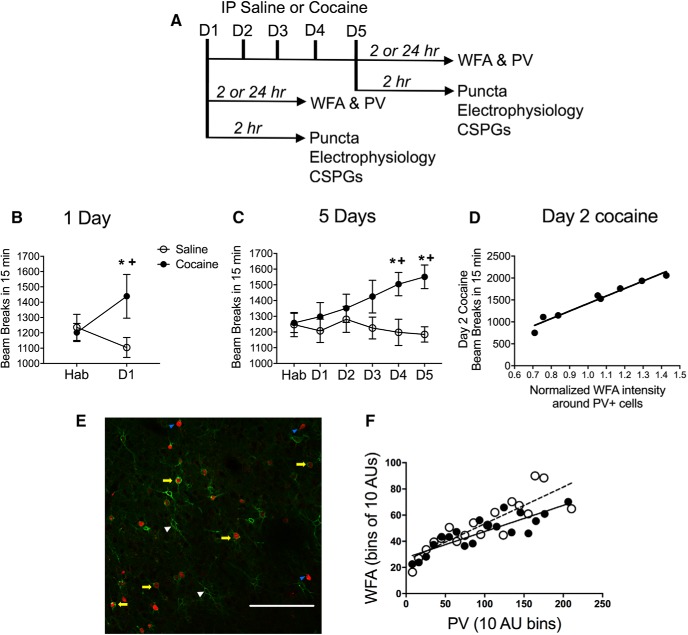
Cocaine exposure increases locomotor activity, and PV intensity is correlated with WFA intensity. Data are the mean ± SEM. A, Timeline of experiment. B, Infrared photocell beam breaks the first 15 min after saline or cocaine injection (15 mg/kg, i.p.). A single cocaine exposure increased the locomotor response compared with the habituation (Hab) day. C, Repeated cocaine increased locomotor activity compared with their Hab day and with saline controls on day 4 (D4) and D5. D, Significant positive correlation between WFA staining intensity in WFA+/PV+ cells and cocaine-induced locomotor activity on day 2 when intensity was examined 2 h after 5 d of cocaine exposure (Fig. 1-1, available at https://doi.org/10.1523/ENEURO.0221-18.2018.f1-1, for all correlations). E, Representative photomicrograph of PV cells (red) with (yellow arrows) and without (blue arrows) WFA (green). WFA was also observed surrounding non-PV cells (white arrows). Scale bar, 100 µm. F, Significant positive correlation between WFA and PV intensity in rats 24 h after 5 d of saline (open circles) or cocaine (closed circles) exposure. For B and C: *p < 0.05, compared with saline group; +p < 0.05, compared with Hab group.